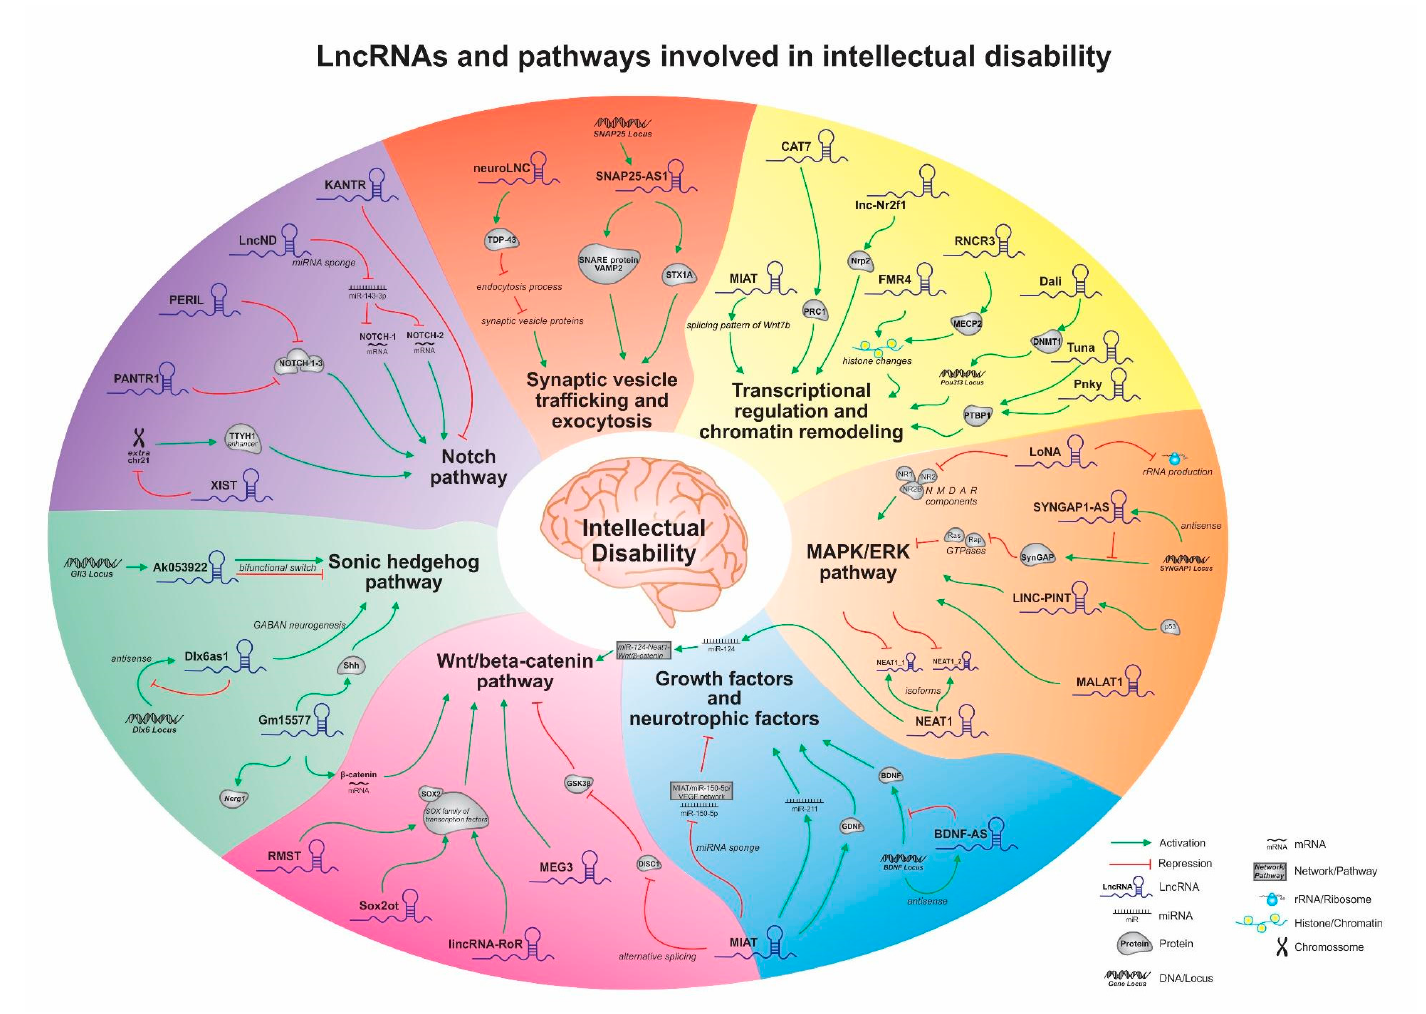
Figure 1. Schematic representation of the mechanisms of action by which lncRNAs may regulate molecular and cellular pathways already associated with non-syndromic intellectual disability and neural function. They play important roles in neurodevelopmental processes, which may have relevant implications for the disease origins and evolution.